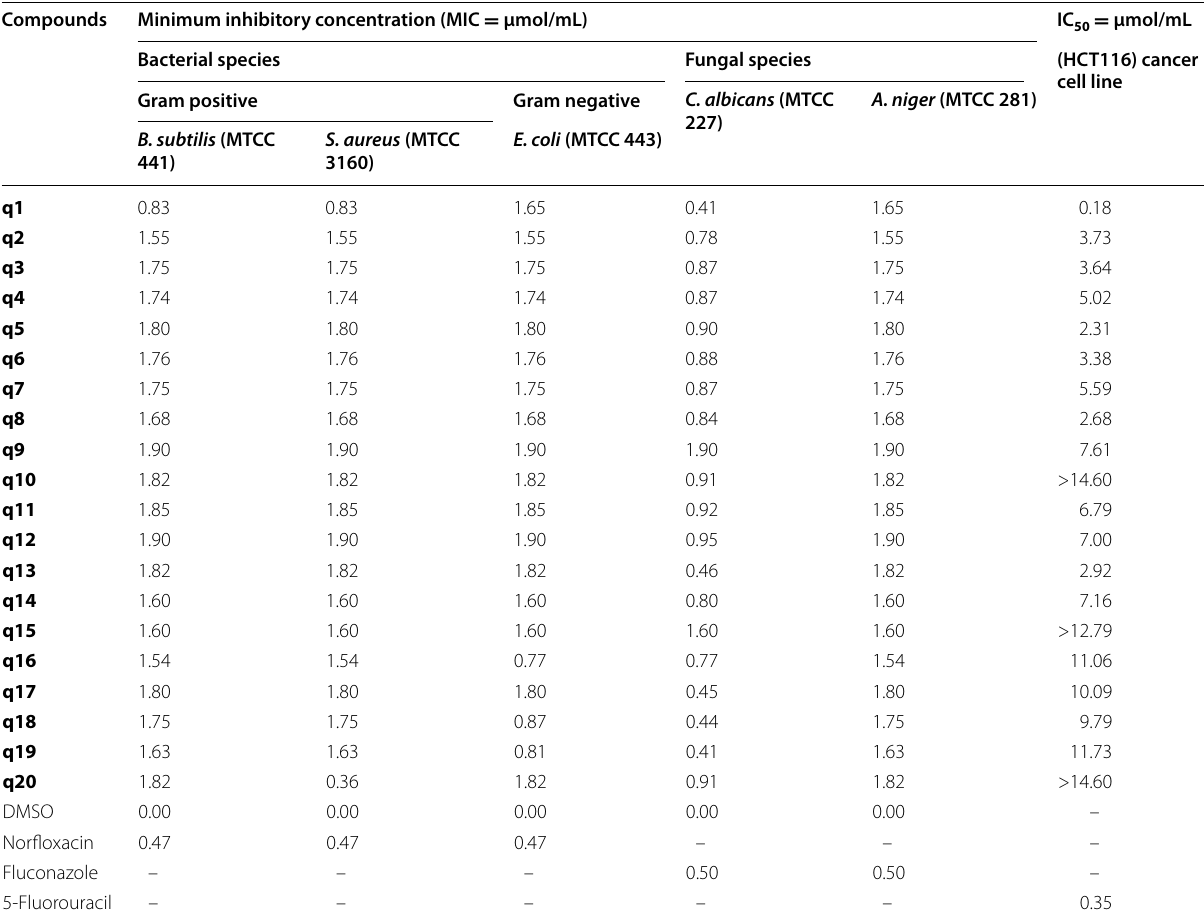
Table 1 Antimicrobial and anticancer activities of synthesized bis-pyrimidine Schiff bases